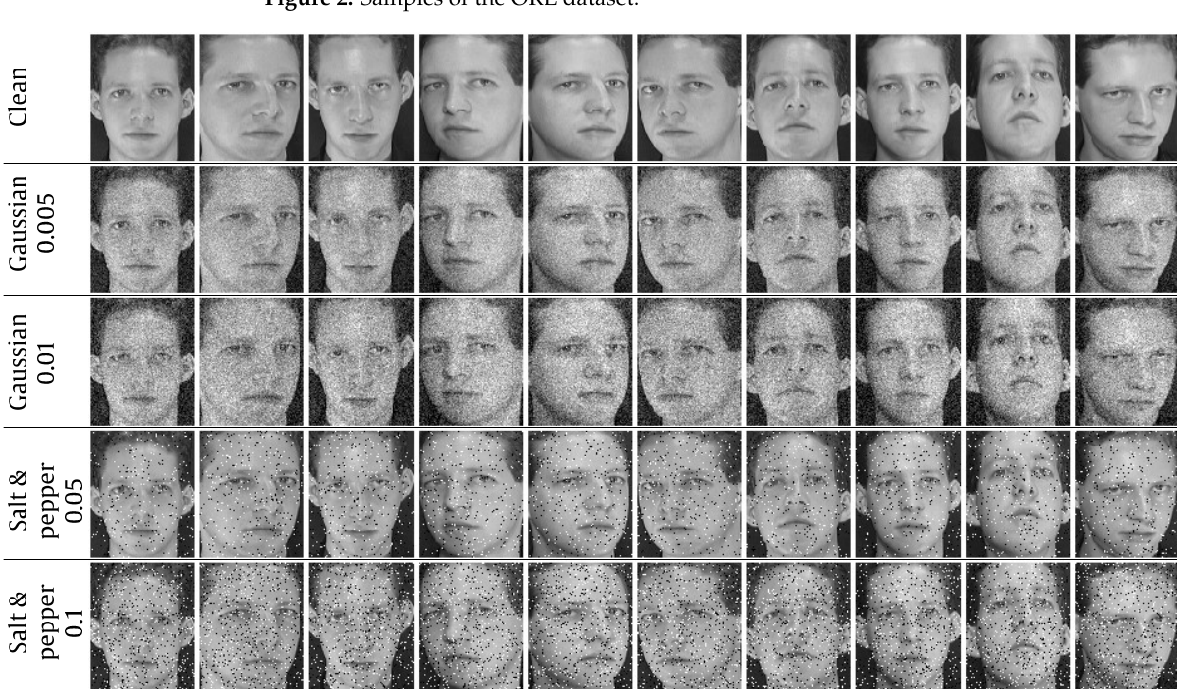
Figure 2. Samples of the ORL dataset.